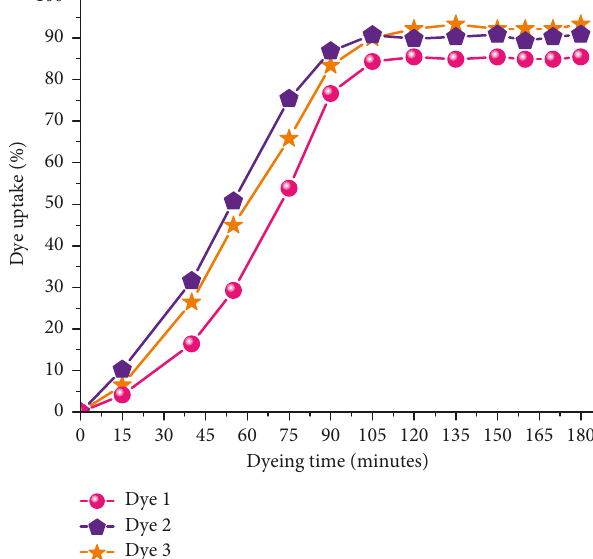
Figure 5: Uptake of the prepared dyestuffs 1 – 4 on polyester